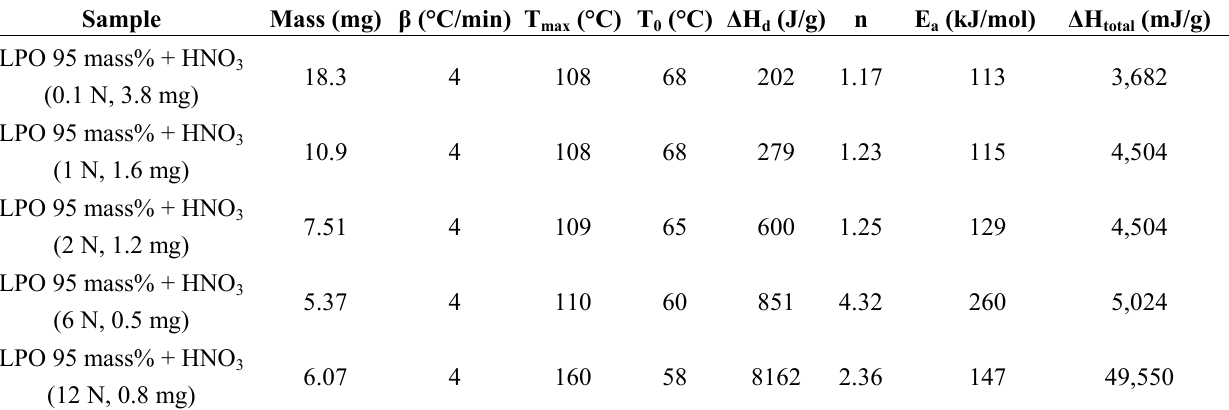
Table 1. Calorimetric data from the dynamic scanning experiments of LPO 95 mass% and for the total peak of the reaction by mixed with HNO 3